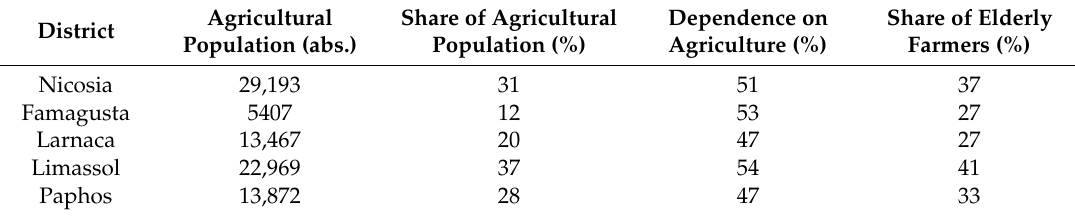
Table 6. Examined characteristics of the agricultural population in Cyprus (district level).